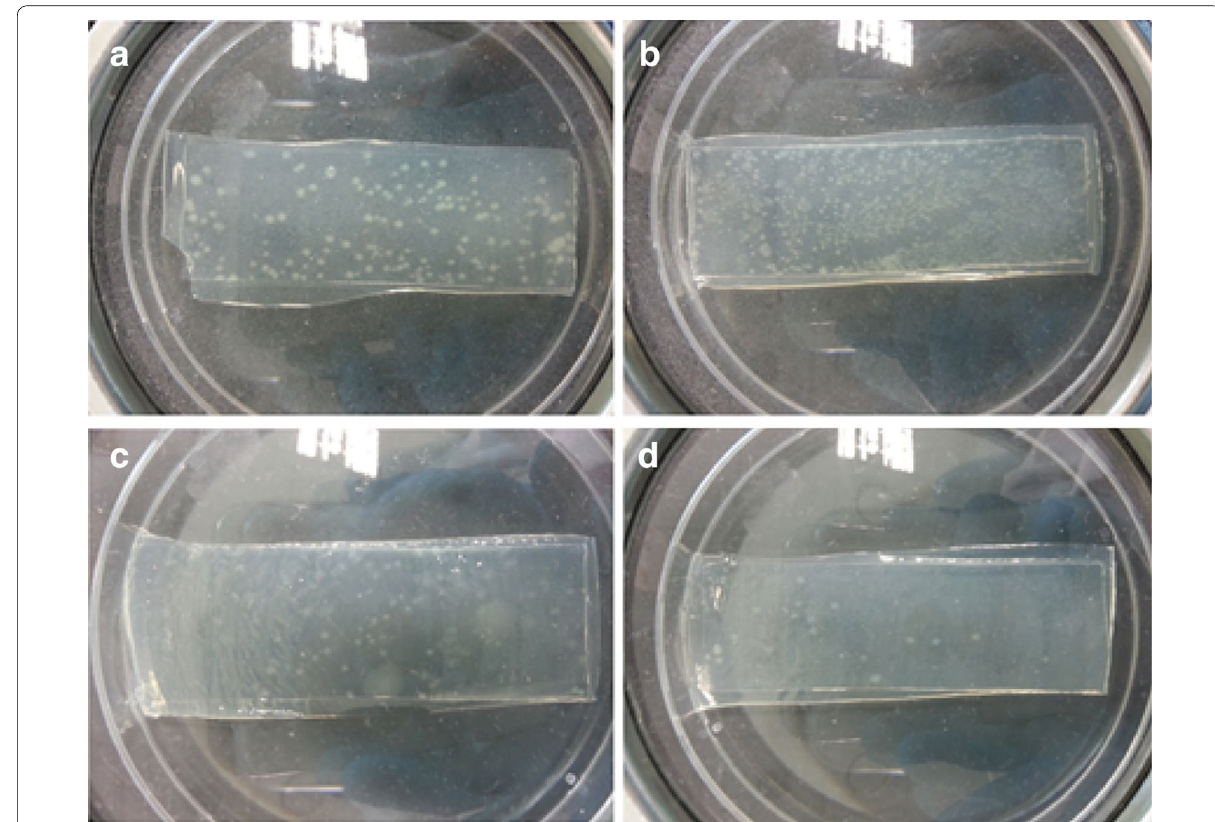
Fig. 3 Effect of organic solvent residues and plasmon treatment time on the antibacterial activity of PDMS films. a Uncleaned and b cleaned PDMS films before the AgNP fabrication. c Plasma untreated and d treated PDMS films with AgNP seeds on the